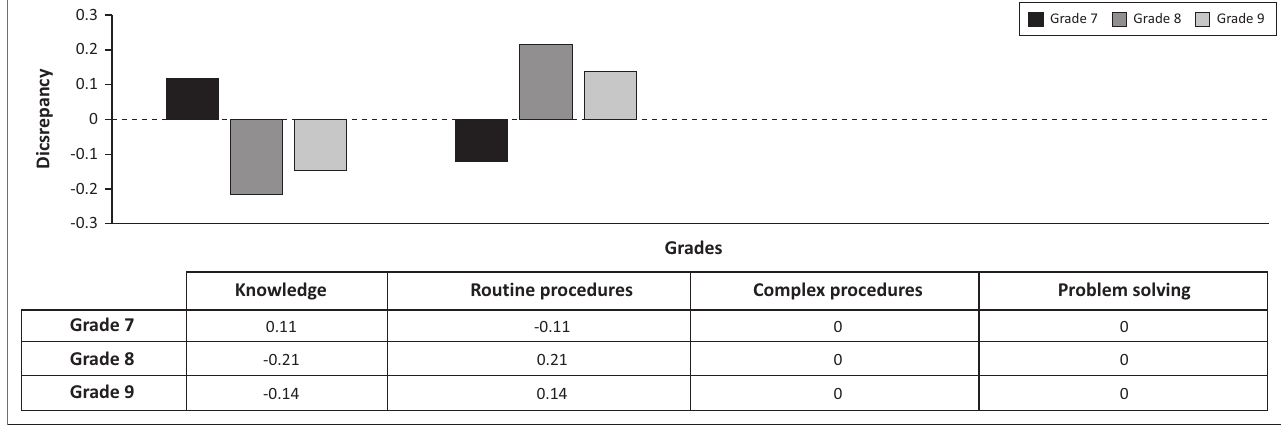
FIGURE 4: Grades 7–9 discrepancies between Senior Phase Mathematics Content Standards and numeric and geometric patterns workbook activities.